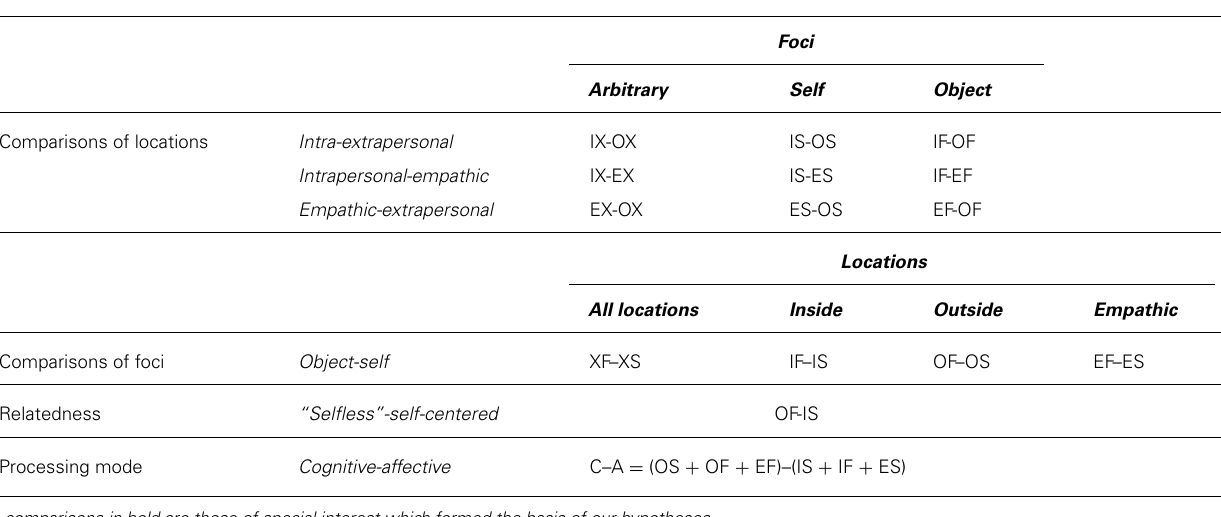
Table 4 |The contrasted conditions are listed